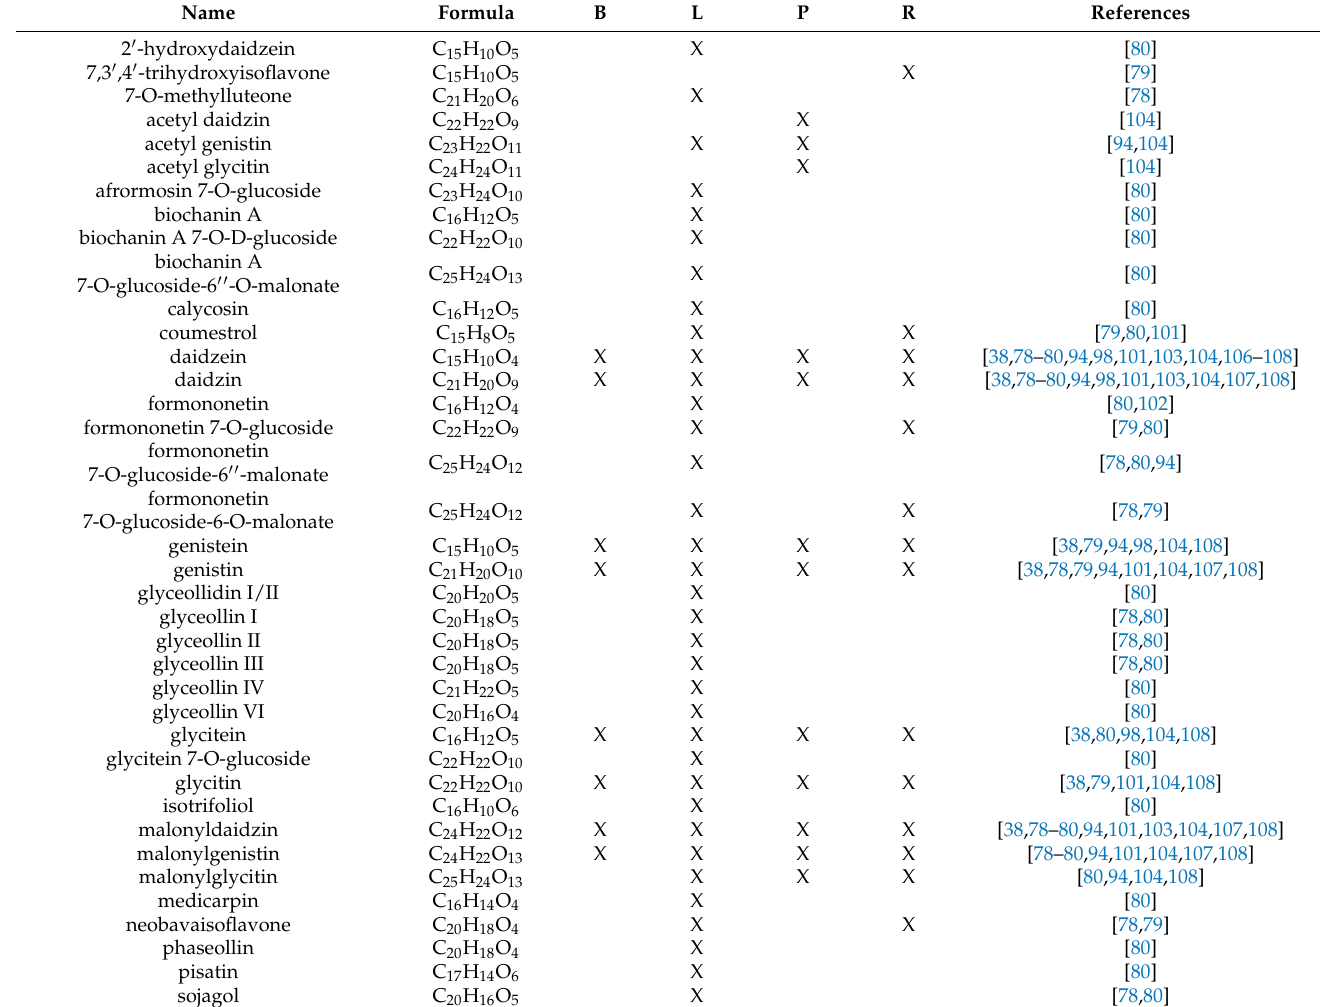
Table 1. Isoflavonoids identified in soy branches (B), leaves (L), pods (P), and roots (R).